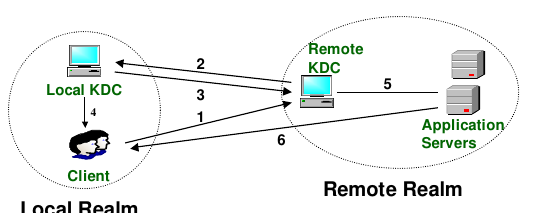
Figure 8. The Message Flow of A New Technique in a Single Remote